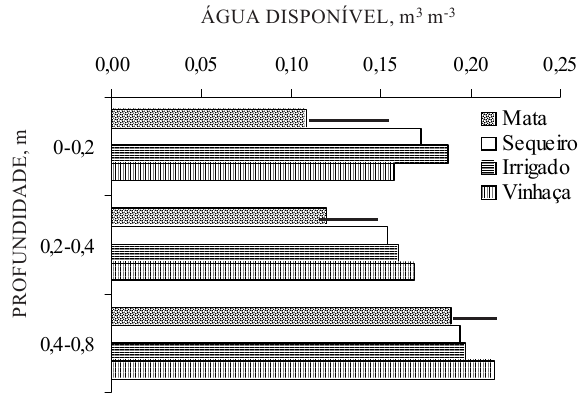
Figura 2. Água disponível para as plantas ( ψψψψψ -10 e -1.500 kPa), considerando os sistemas de uso e manejo nas profundidades